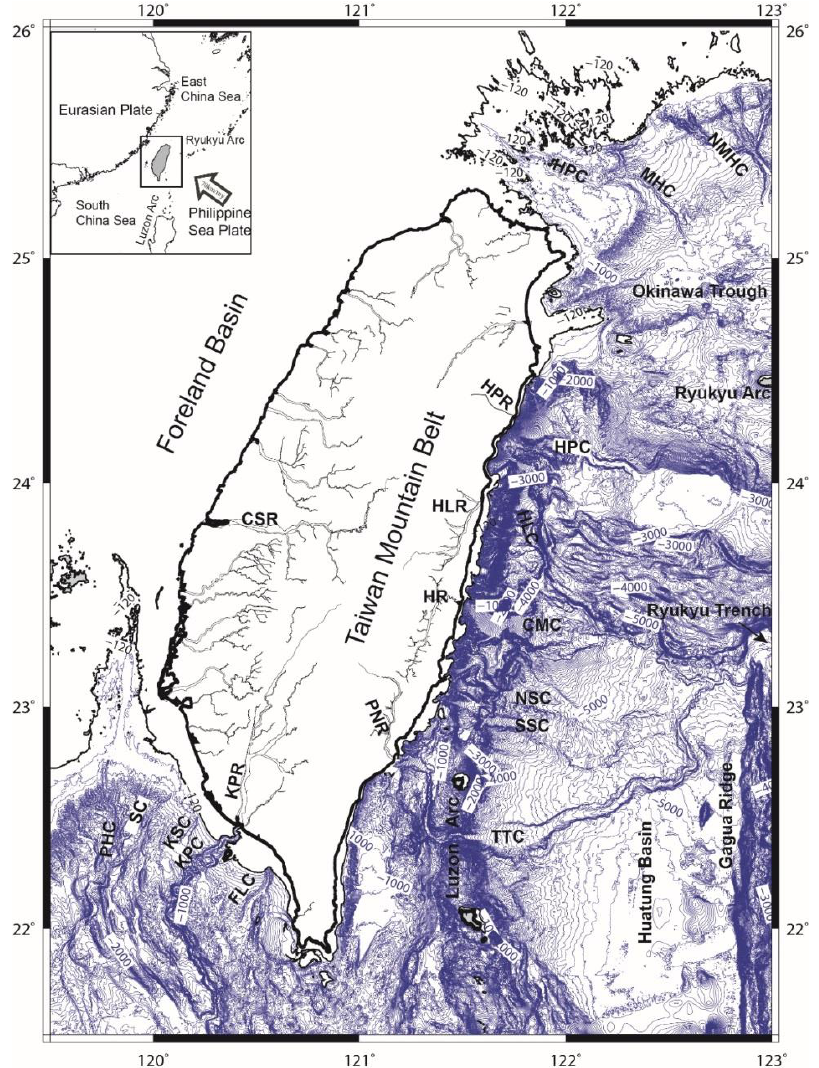
Figure 1. Map showing river drainage and the surrounding bathymetric contours of Taiwan Island. Note the outline of the 120 m depth contour off the shore of Taiwan. Noticeable submarine canyons have developed on the shelf – slope regions. The inset in the upper-left corner shows the tectonic setting of Taiwan. CSR: Choshui River; KPR: Kaoping River; HPR: Hoping River; HLR: Hualien River; HR: Hsiukuluan River; PNR: Peinan River; PHC: Penghu Canyon; SSC: Shoushan Canyon: KHC: Kaohsiung Canyon; KPC: Kaoping Canyon; FLC: Fangliao Canyon; HPC: Huapinghsu Chan- nel; MC: Mienhua Canyon; NMC: North Mienhua Canyon; HPC: Hoping Canyon; HLC: Hualien Canyon; CMC: Chimei Canyon; NSC: North Sanxian Canyons; SSC: South Sanxian Canyons; TTC: Taitung